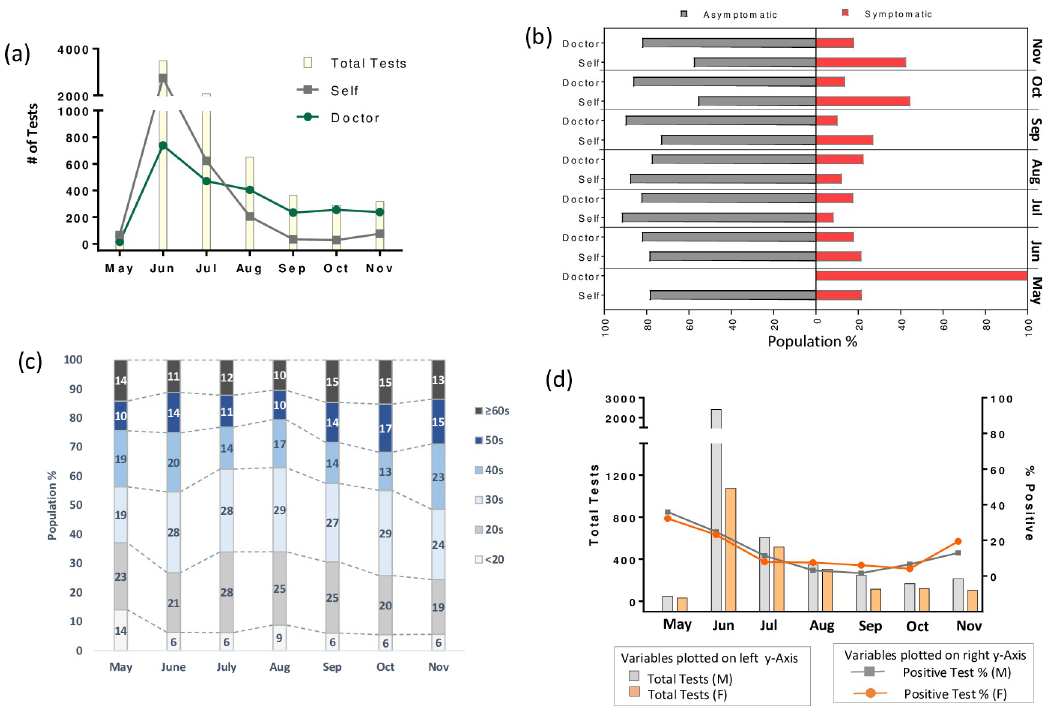
Fig 1. Description of the cohort. (a) The total number of tests performed for the presented work upon doctor’s recommendation or self-motivation. (b) Percentage of symptomatic and asymptomatic participants reaching out for COVID-19 testing upon doctor’s advice or self-motivation. (c) Age-distribution of the cohort (d) COVID-19 new tests per thousand people (males or females) ( left y-axis , vertical lines), and positive test percentage for males and females ( right y-axis , stacked line) between May